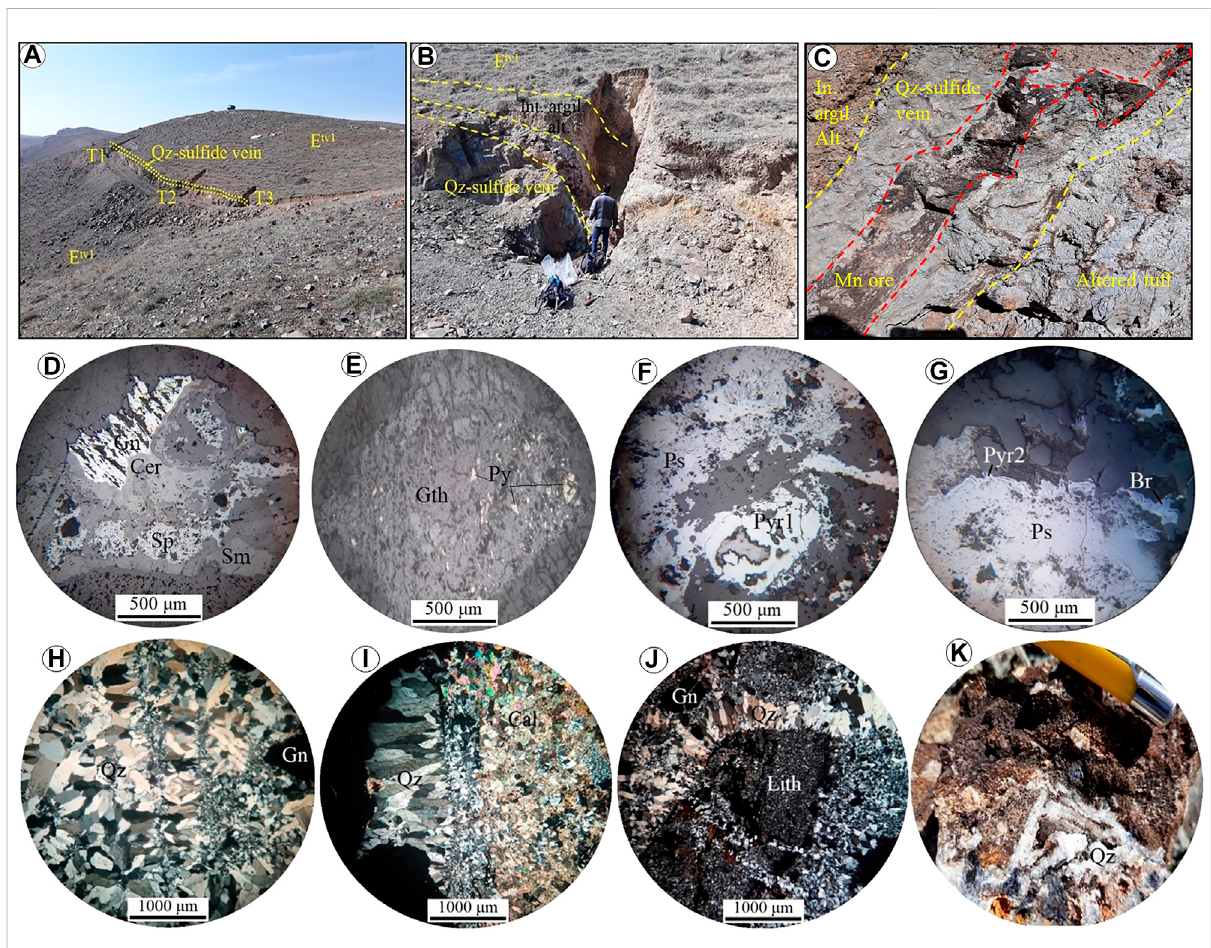
FIGURE 6 Photographs are showing features of the ore veins, mineralogy, and textures at the Varmazyar deposit. Images in (D – G) are from polished blocks in re fl ected light, while (H – J) are taken in transmitted light, XPL. (A) . General view of the quartz-sul fi de ore vein hosted by the E tv1 unit of the KarajFormation,lookingsouthwest. (B) .Quartz-sul fi deoreveincoveredby2 mwideintermediateargillicalterationhalointhehangingwall,looking west. (C) . Quartz-sul fi de ore vein crosscutting by Mn-bearing quartz-calcite veins. (D) . Intergrowth of galena and sphalerite. Both minerals, respectively, altered to cerussite and smithsonite along boundaries. (E) . Anhedral pyrite crystal altered to goethite. (F) . Intergrowth of psilomelane and primary pyrolusite. (G) . Anhedral to subhedral psilomelane crystals altered to secondary pyrolusite and braunite along boundaries. (H,I) . Crustiform texture of quartz in quartz-sul fi de (H) and quartz-calcite (I) veinlets. In I, the plumose texture of quartz is also observed. (J) . Cockade texture of quartz developed around tuff fragments. (K) . Lattice-bladed calcite was replaced by quartz along with colloform texture of quartz. Abbreviations as in Figure